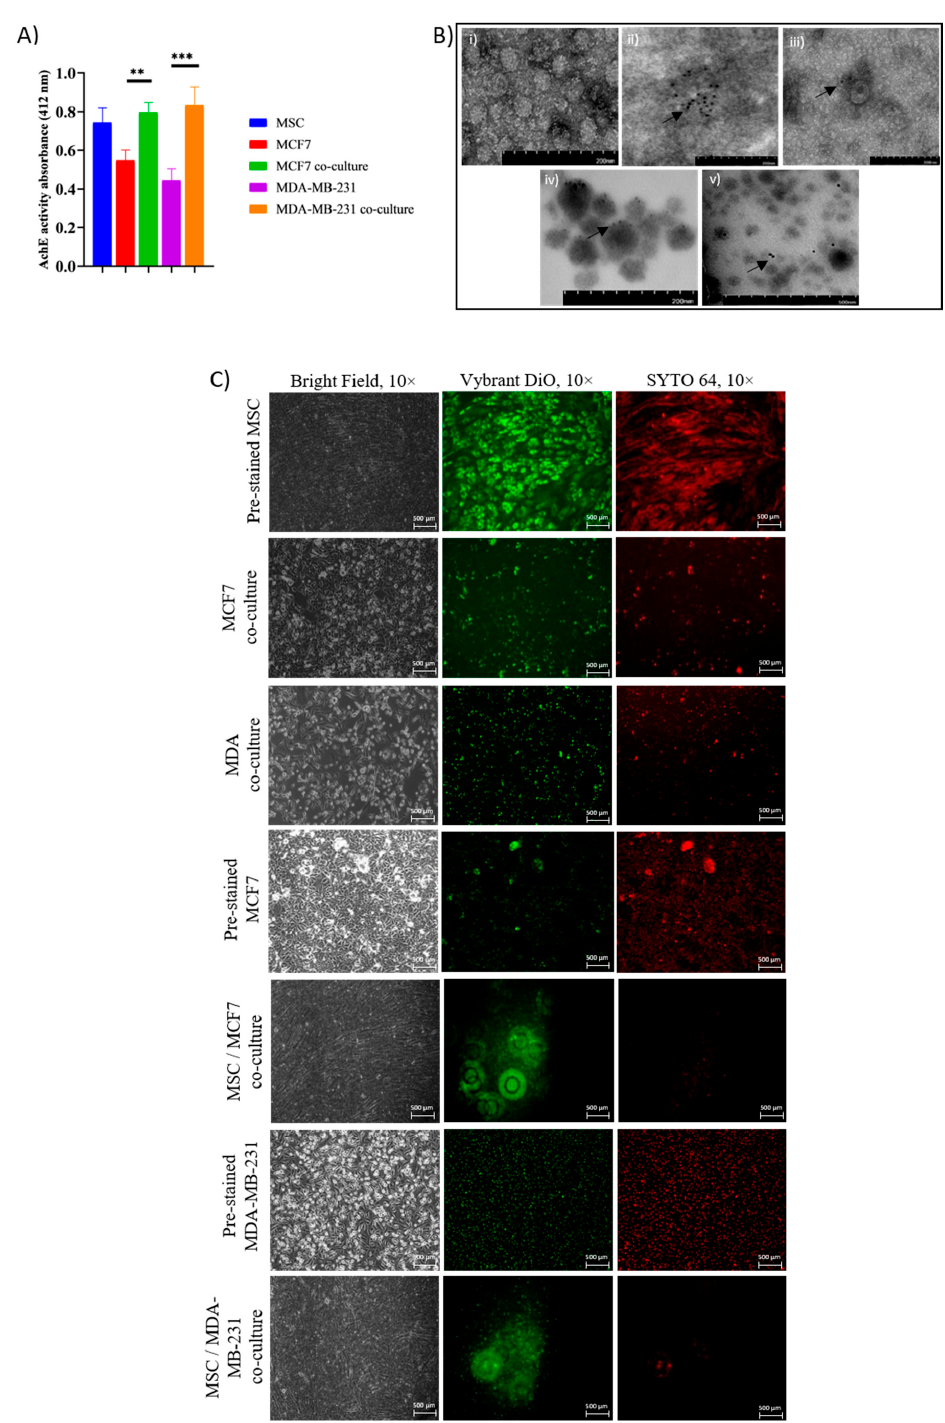
Figure 3. Characterization and intercellular transfer of exosomes. ( A ) A graph showing the enzymatic activity acetylcholine esterase (AchE) of isolated co-culture exosomes. ( B ) Representative image of transmission electron microscopy (TEM) of cells-derived exosomes; (i) negative staining-no primary antibody, (ii–v) exosomes stained with gold-conjugates secondary antibody to anti-CD81, anti-CD9, anti-CD63 and anti-TSG101 (80k × magnification). The arrow indicates the golden particles of the secondary antibody which represents the presence of protein markers CD81, CD9, CD63 and TSG101. ( C ) Intercellular transfer of exosomes and RNAs was visualized through membrane and RNAs staining with Vybrant DiO and SYTO 64 fluorescence dyes (10 × magnification). The results were analyzed using ANOVA with mean values ± SD. ** p < 0.01 and *** p < 0.001 compared with the control